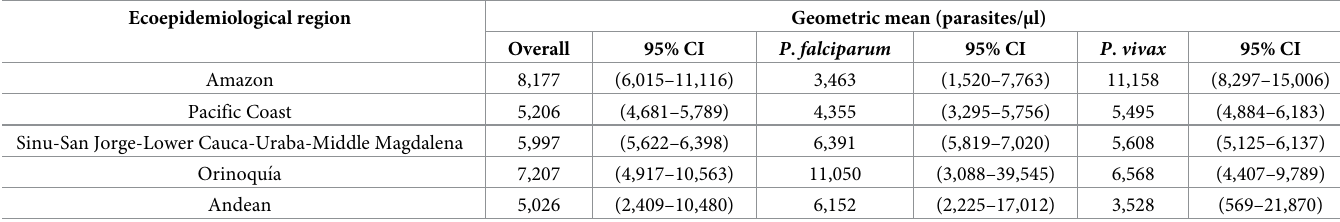
Table 2. Distribution of parasite density levels in severe malaria by ecoepidemiological region and parasite species in Colombia, 2014–2017. Ecoepidemiological